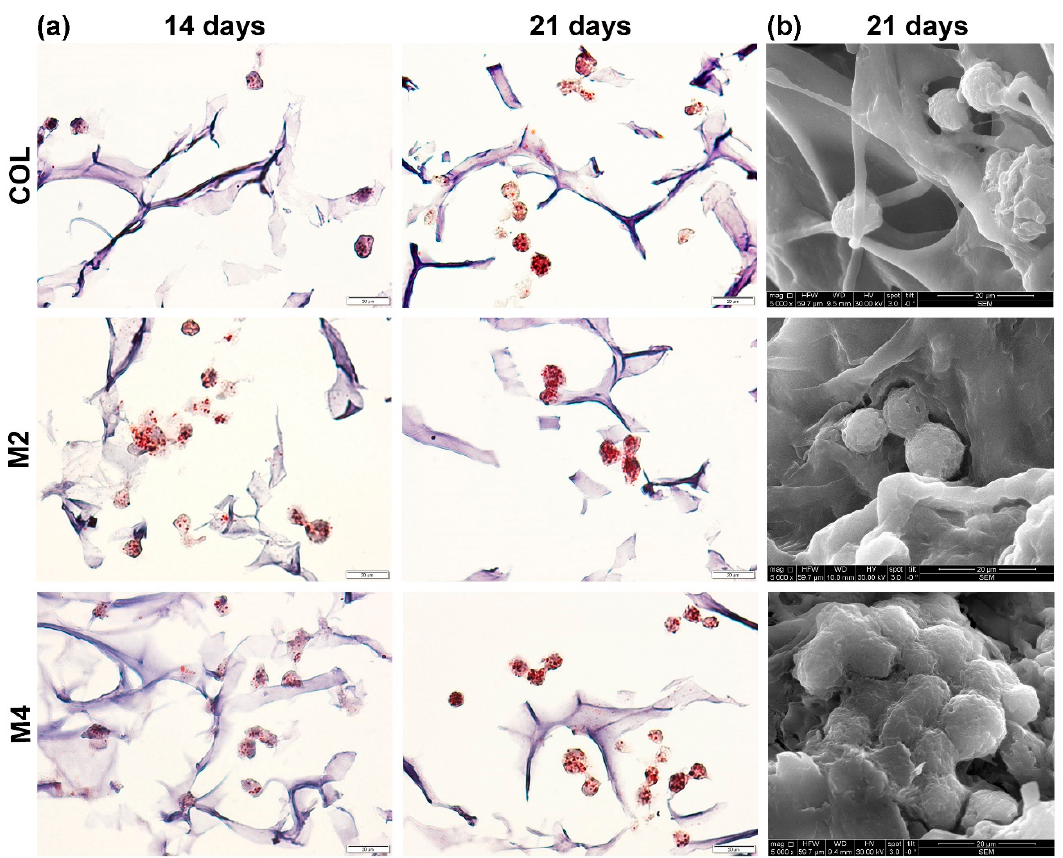
Figure 2. ( a ) Evaluation of intracellular lipid accumulation after 14 and 21 days of hASCs adipogenic di ff erentiation using Oil Red O staining; ( b ) Rounded phenotype of di ff erentiated cells visualized by SEM after 21 days of adipogenic di ff